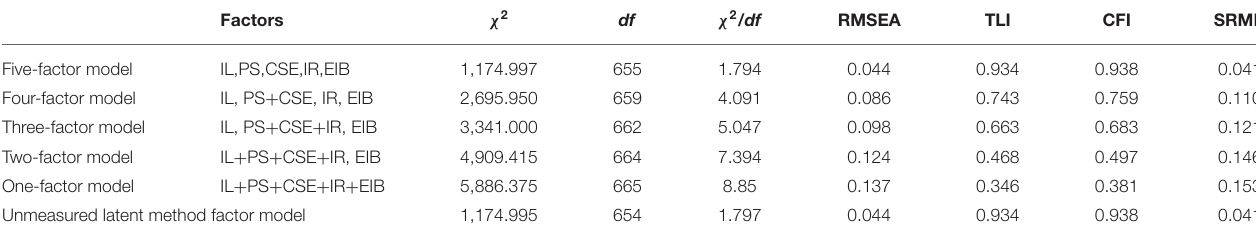
TABLE 1 | Results of confirmatory factor analyses.